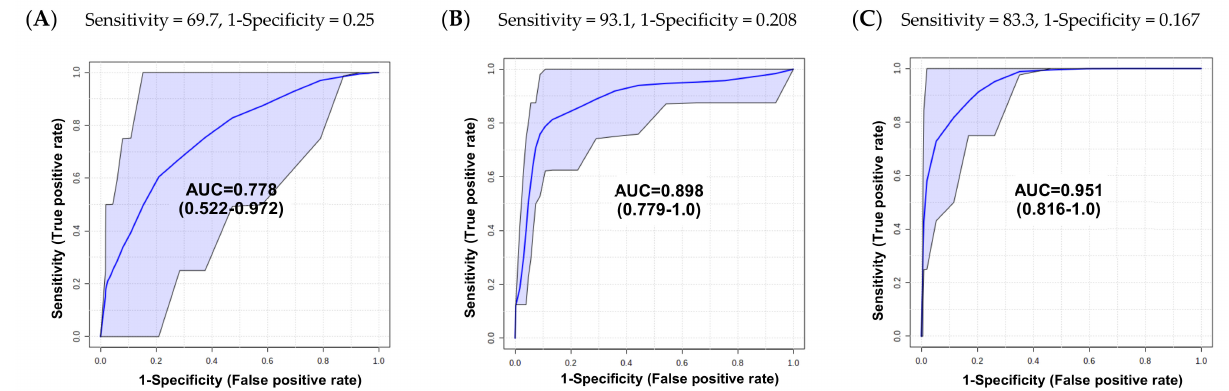
Figure 4. Combined multivariate ROC curves between cancer groups. ( A ) The AUC for creatinine and glutamine to discriminate BCa from RCC was 0.778 (95% CI, 0.522–0.972). ( B ) The AUC for 4-HBA, N-MH, and creatinine to discriminate PCa from BCa was 0.898 (95% CI, 0.779–1.0). ( C ) The AUC for 4-HBA, N-MH, glutamine, and acetate to discriminate PCa from RCC was 0.951 (95% CI,